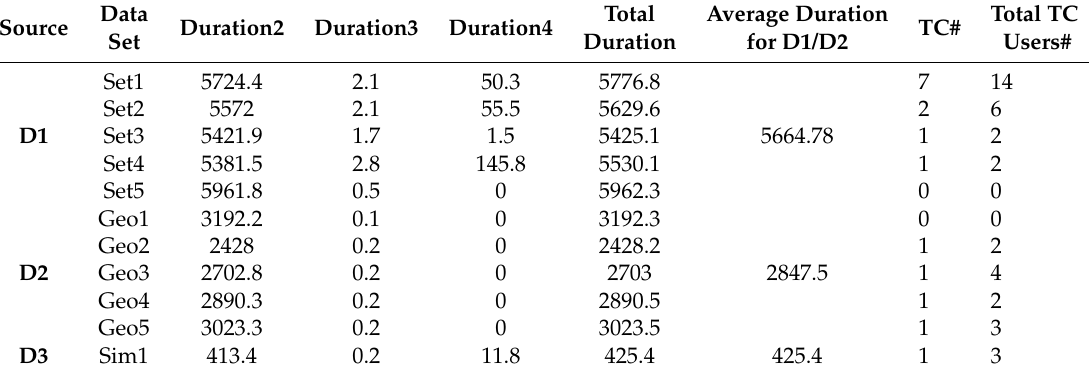
Table 5. Time Overhead in Main Stages and The Number of Results.